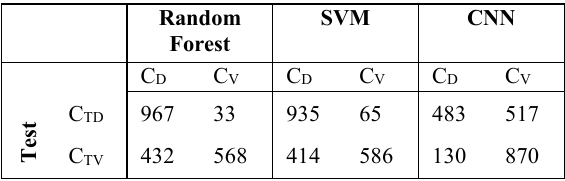
Table 1 . Confusion matrices regarding classification results of